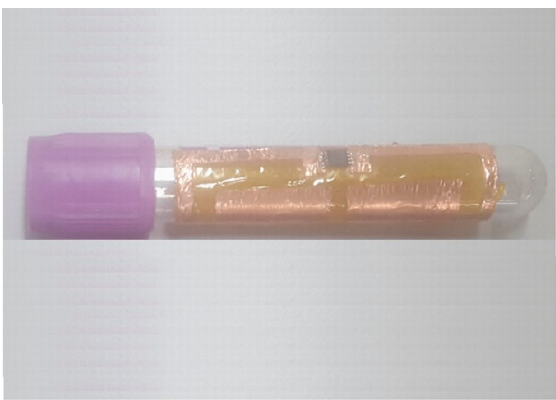
Figure 6. Photograph of the proposed flexible UHF RFID tag antenna attached to the smallest blood tube.